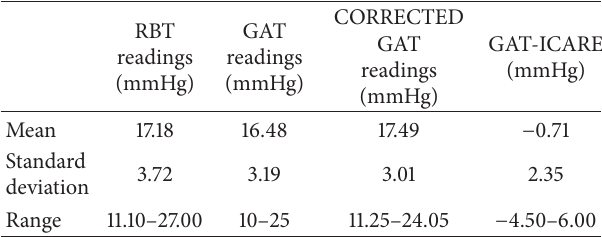
Table 1: IOP measurement